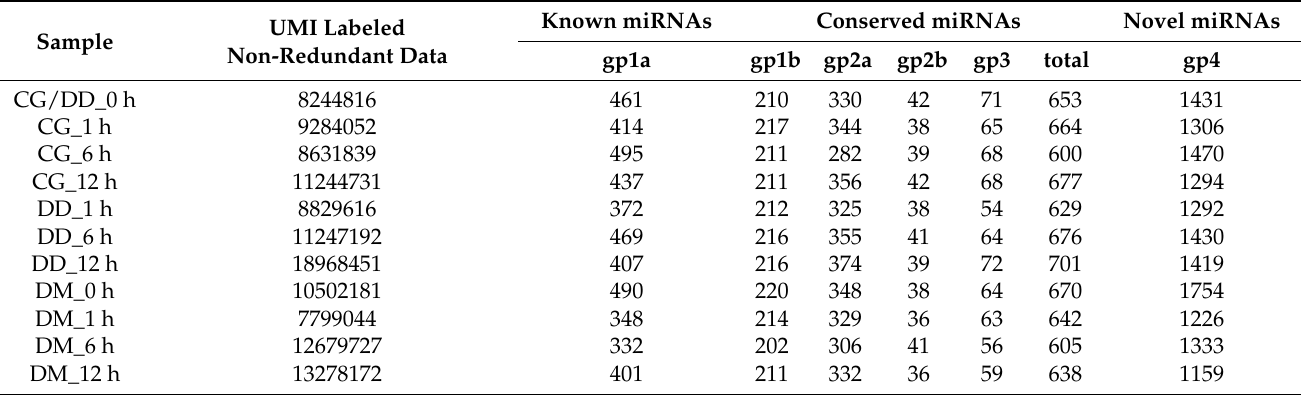
Table 1. The miRNA sequence data